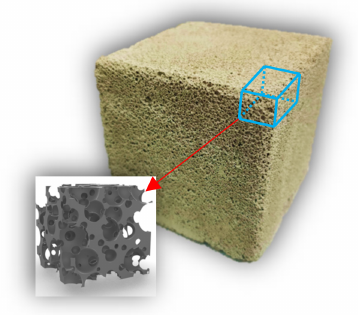
Figure 2. The model for the structure of the solidified